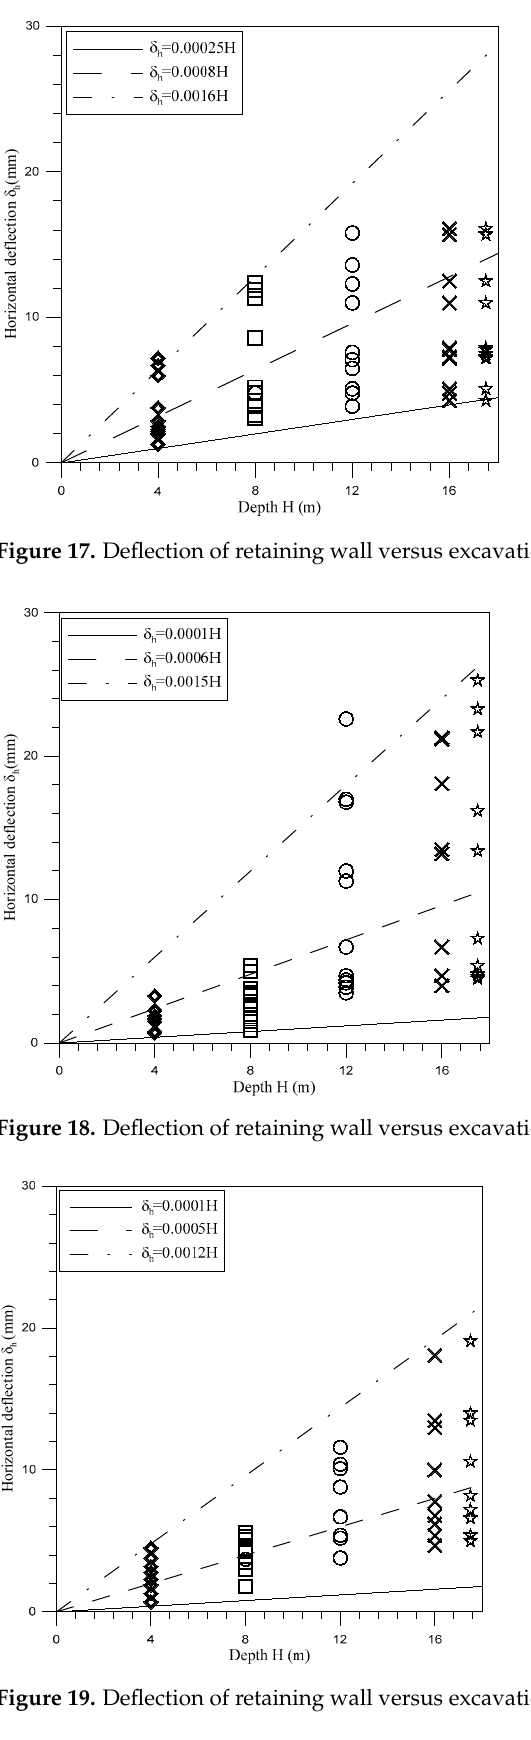
16 of 21 Figure 16. Ground surface settlement versus distance from the retaining wall. 3.7. Relationship between Horizontal Deflection and Excavation Depth of Retaining Wall The relationship between the horizontal deflection at the top of the retaining wall and the excavation depth is shown in Figures 17–19, and these data were recorded until the excavation reached the final depth. Generally, the maximum horizontal deflection does not occur at the top of a braced or anchored retaining wall. The horizontal movement along the depth of the retaining wall was not recorded in this study; therefore, the rela- tionship between the maximum horizontal movement and the depth of the excavation could not be determined in this study. The recorded deflection at the top of the retaining wall lay in 0.01–0.16% H in this excavation (Figures 17–19), which was much smaller than the maximum deflection values in other excavations in soft soils: 0.1–1.0% H for deep ex- cavations constructed with the bottom-up technique based on a large number of cases in Shanghai [3]; 3.2% H [1] and 0.1–10.1% H [2] for worldwide cases, but closer to 0.05–0.55% H based on 92 braced excavations in China [27]; and 0.1–0.55% H for most of 592 deep